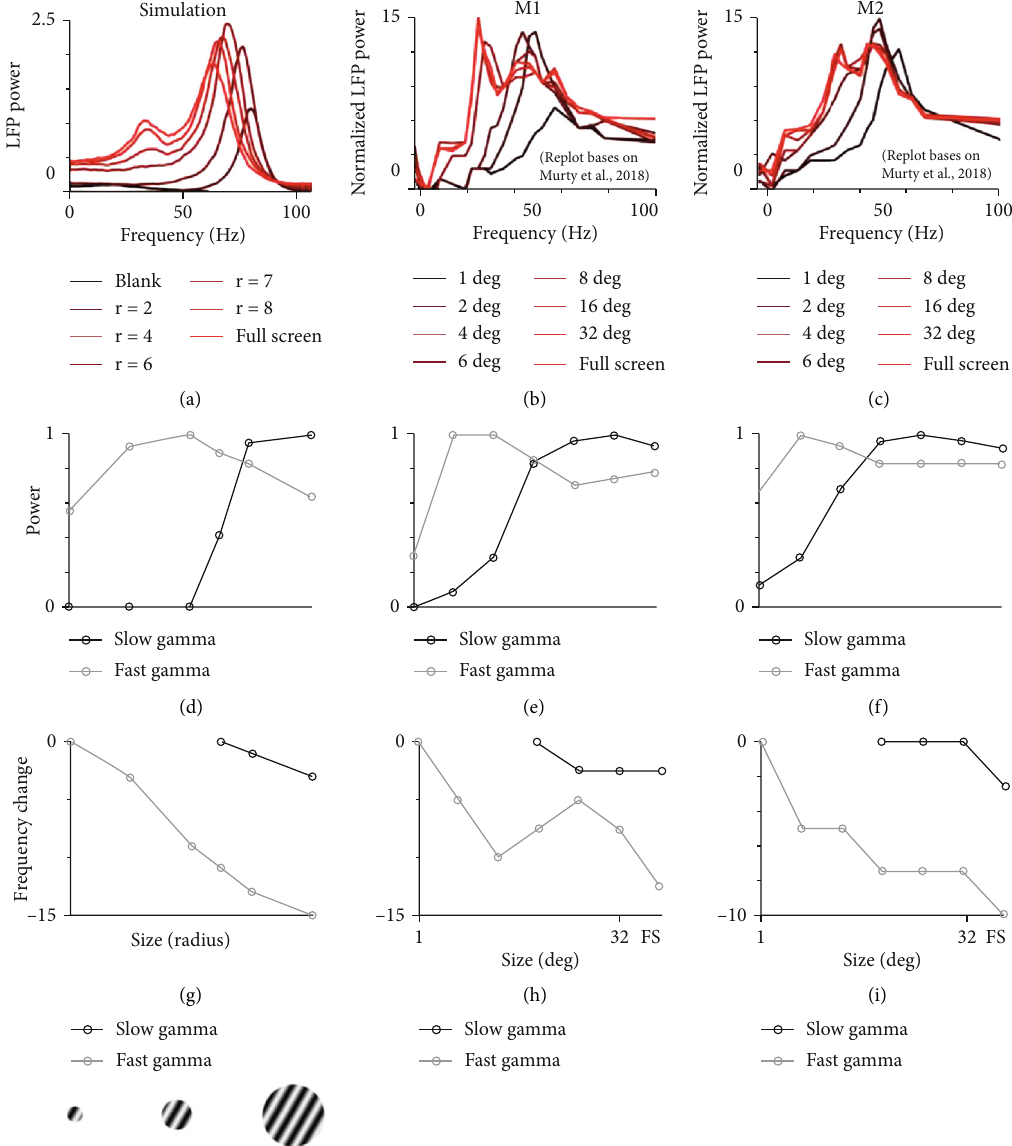
Figure 6: The size dependence of gamma in the model matches experimental results. (a) shows power spectrums of the LFP induced by stimuli at di ff erent sizes in our fully connected network. Di ff erent stimulus sizes are labelled in di ff erent colors. (b) and (c) show how power spectrums (normalized by the response of blank stimuli) change with stimulus sizes in V1 of two monkeys M1 and M2 (Murty et al. 2018). Note: (b) and (c) are replotted based on a recent publication (Murty et al. 2018). (d – f) shows the tuning curves of stimulus size from model simulation, monkey M1 and M2, respectively. The peak value in each tuning curve was normalized peak power for slow (black curve) and fast gamma (grey curve). (g – i) show the tuning curves of stimulus size from model simulation, monkey M1 and M2, respectively. The peak frequency was shown as frequency relative to the highest frequency for slow (black curve) and fast gamma (grey